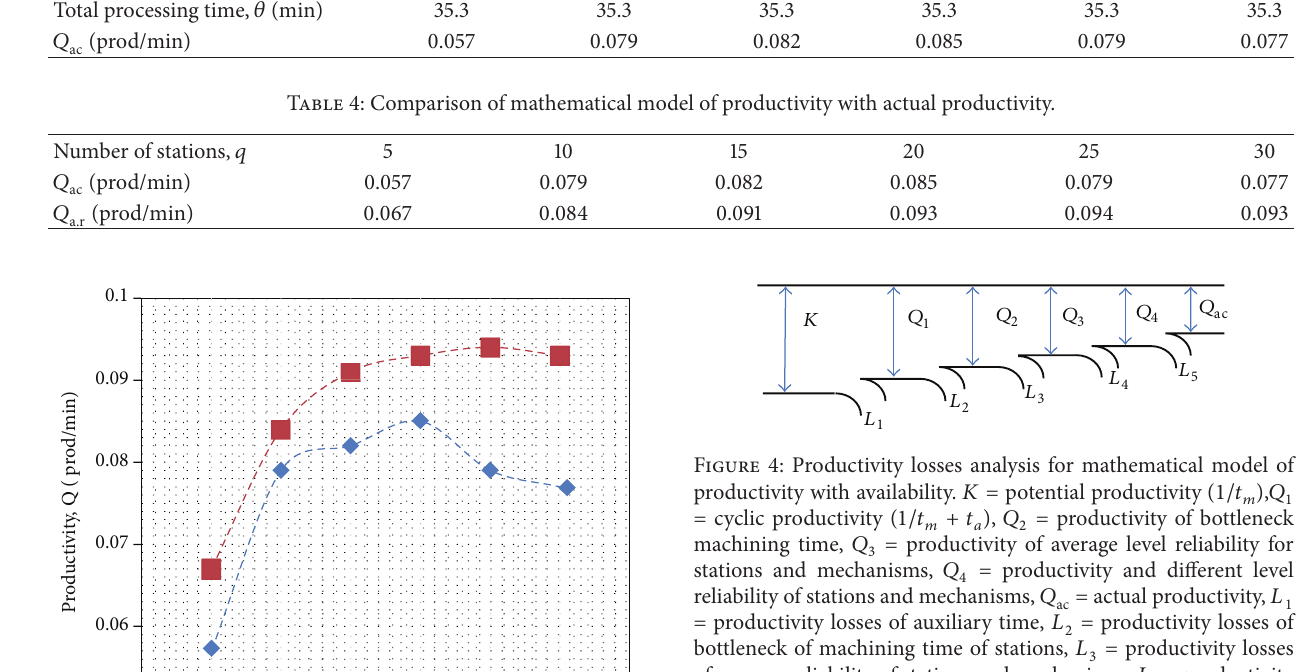
Figure 3: Graph of actual productivity (𝑄 productivity (𝑄